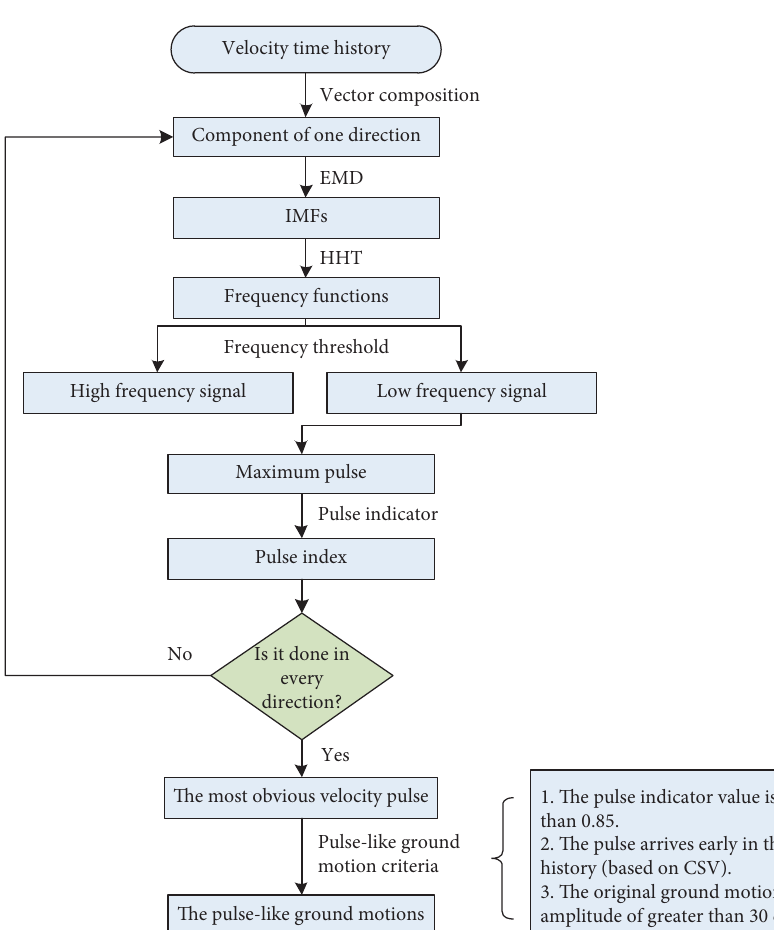
Figure 2: The flowchart of improved Baker method based on